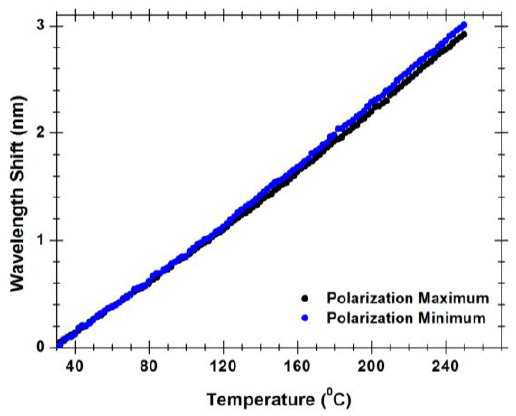
Figure 7. Output signal for different polarization states. Black line : Maximum polarization state; Blue line : Minimum polarization state.